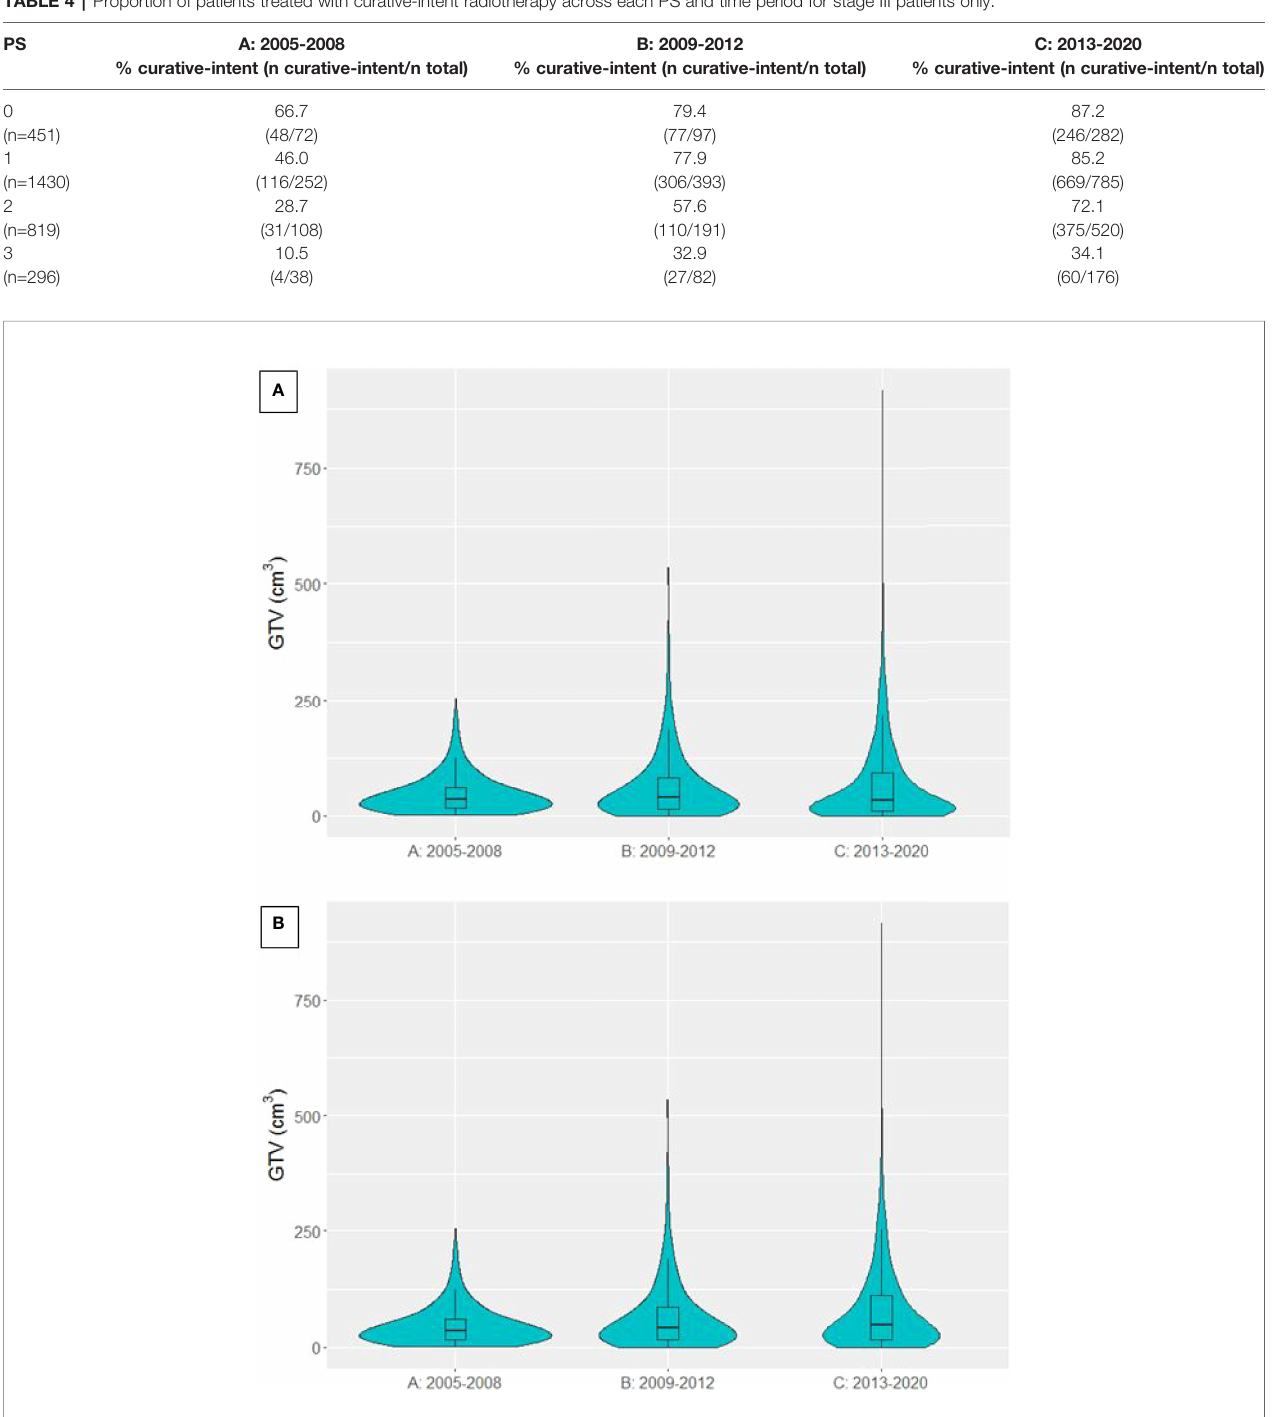
FIGURE 4 | Violin plot presenting the distribution of GTVs in patients treated with curative-intent radiotherapy in each time period. (A) SABR patients included (B) SABR patients